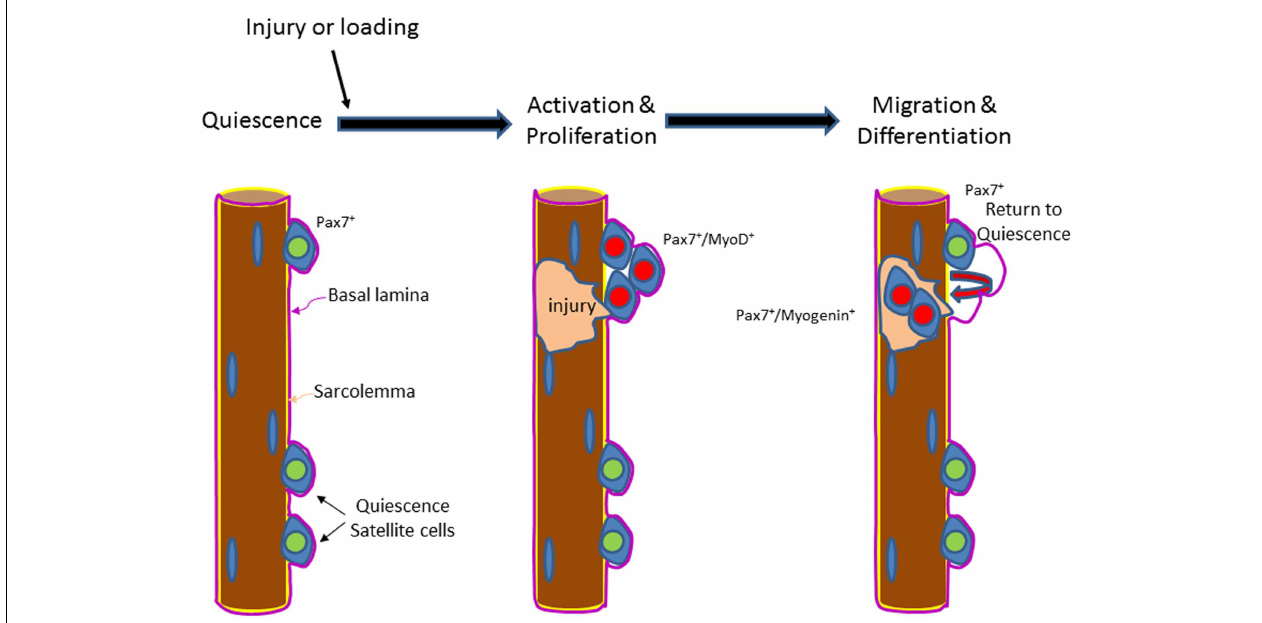
daughter cells from the original satellite cells leave their position and pass through the sarcolemma and migrate to the site of injury, where they fuse with the existing fiber and engage in fiber repair and/or contribute to fiber growth/hypertrophy. In aging and sarcopenic muscles, satellite cell proliferation and/or differentiation may be impaired, which contribute to a lower regenerative